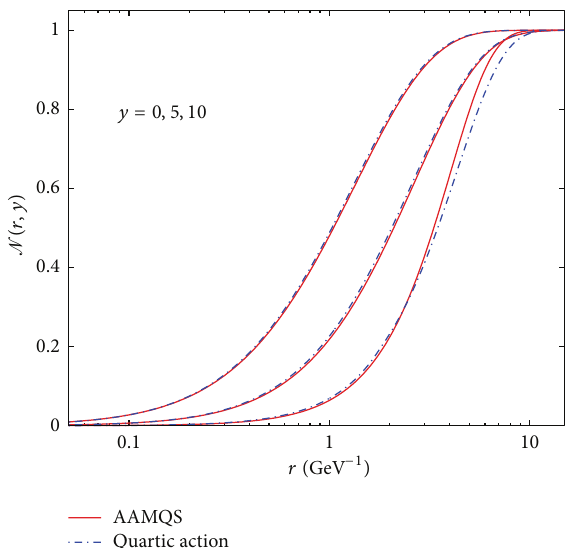
Figure 2: Dipole scattering amplitude N (𝑟, 𝑦) in coordinate space at different rapidities with two different initial conditions indicated in the figure. From the right curve to the left one, the corresponding rapidities are 𝑦 = 0 , 5, and 10, respectively.